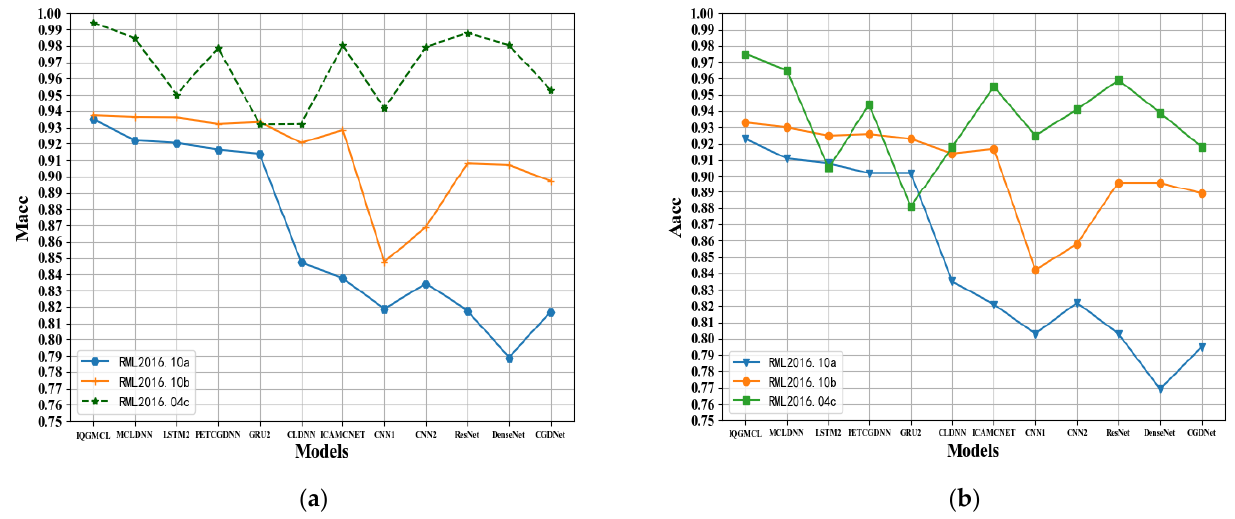
Figure 8. Macc and Aacc of each network on three datasets. ( a ) Comparison of the maximum recognition accuracy of each network; ( b ) comparison of the average recognition accuracy of each network.